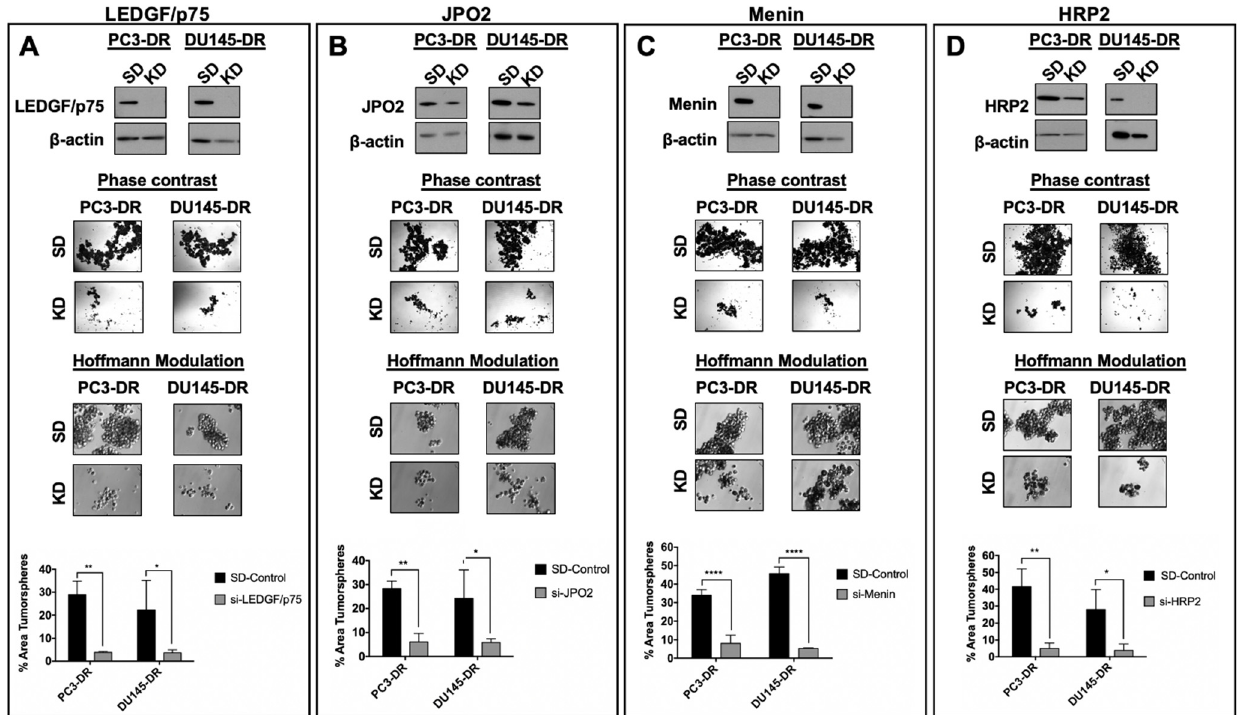
Figure 9. Knockdown of LEDGF/p75, JPO2, menin, or HRP2 impairs tumorsphere formation in PC3-DR and DU145-DR cells. siRNA-mediated knockdowns of LEDGF/p75 ( A ), JPO2 ( B ), menin ( C ), and HRP2 ( D ) were confirmed by immunoblotting in PC3-DR and DU145-DR cells transfected with specific siRNAs (KD) compared to cells transfected with SD control oligos. Representative images of tumorsphere formation assays showing a decrease in spheroid size in PC3-DR and DU145-DR cells after individual siRNA-mediated depletion of LEDGF/p75, JPO2, menin, or HRP2 compared to SD control spheres. Tumorspheres were visualized using phase contrast or Hoffman Modulation Contrast microscopy. Tumorsphere area was quantified (bottom graphs) from triplicate images per experiment using ImageJ software. Data are from at least 3 independent experiments and are represented as mean SEM. * p < 0.05, ** p < 0.01, **** p < 0.0001.